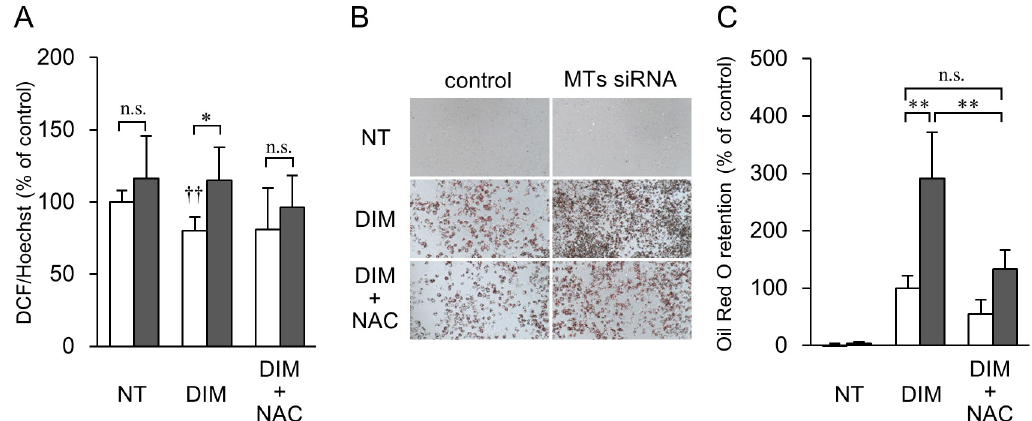
Fig 8. Effect of ROS on lipid accumulation in 3T3-L1 cells pretreatedwith MTs siRNA. (A) Production of ROS was determined using the DHFH-DA method. After pre-treatment with control RNA (open columns) or MTs siRNA (closedcolumns), 3T3-L1 cells were incubatedin the presenceor absenceof 1 μ M DEX, 0.5 mM IBMX, and 1 mM NAC for 1 h. Serum-free medium, including10 μ M DCFH-DA was then added to the cells for 30 min, in the presenceor absenceof 1 μ g/mL insulin. After the cells had beenfixed, ROS levels were measured as describedin the Materials and Methods section. NT, non-treatment with DIM (DEX, IBMX, and insulin); DIM, treatment with DIM; DIM + NAC, treatment with DIM and 1 mM NAC. Data are expressedas the mean ± SD ( n = 5). * and ** represent P values of < 0.05 and < 0.01, respectively. †† representsa P value of < 0.01 vs 3T3-L1 cells pretreated with siRNA control and not with DIM. n.s., not significant.(B) Representative images of Oil Red O staining in 3T3-L1 preadipocytes and adipocytes. 3T3-L1 cells were pretreatedwith control RNA or MTs siRNA for 24 h. Adipogenicdifferentiation of 3T3-L1 was then initiated with DIM (shown as DIM) or DIM and 1 mM NAC (DIM + NAC). On day 2, the culture medium was changedto medium supplemented with 1 μ g/ml insulin. On or after day 4, the medium was replacedevery two days. Naturallipids in the fixed cells were stained with Oil Red O. Non-differentiated 3T3-L1 preadipocytes are shown as NT. (C) Absorbance of Oil Red O was measured, and Oil Red O retention is expressedas a percentage of retention by the control RNA-treated cells. Data are expressedas the mean ± SD ( n = 5). ** representsa P value of < 0.01.